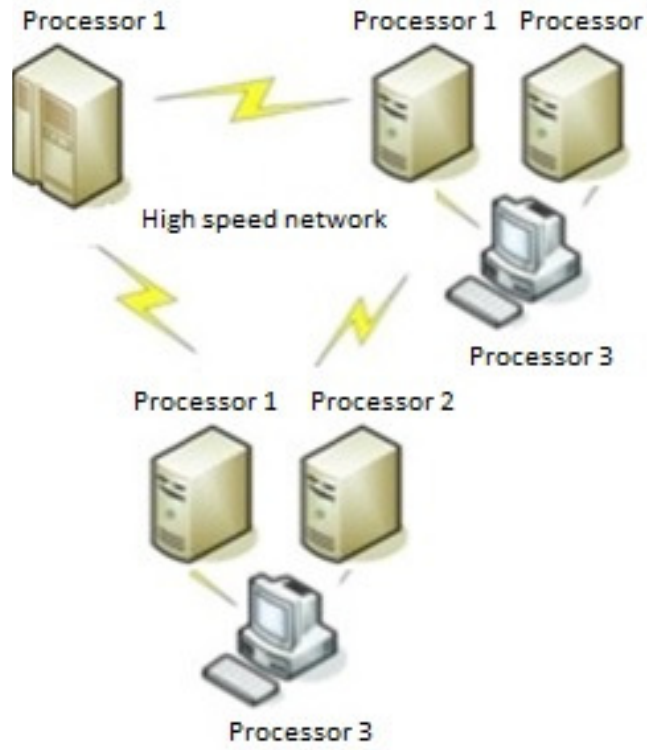
Figure 1. Heterogeneous distributed computer system (HDCS) with 3 clusters joined by a high-speed